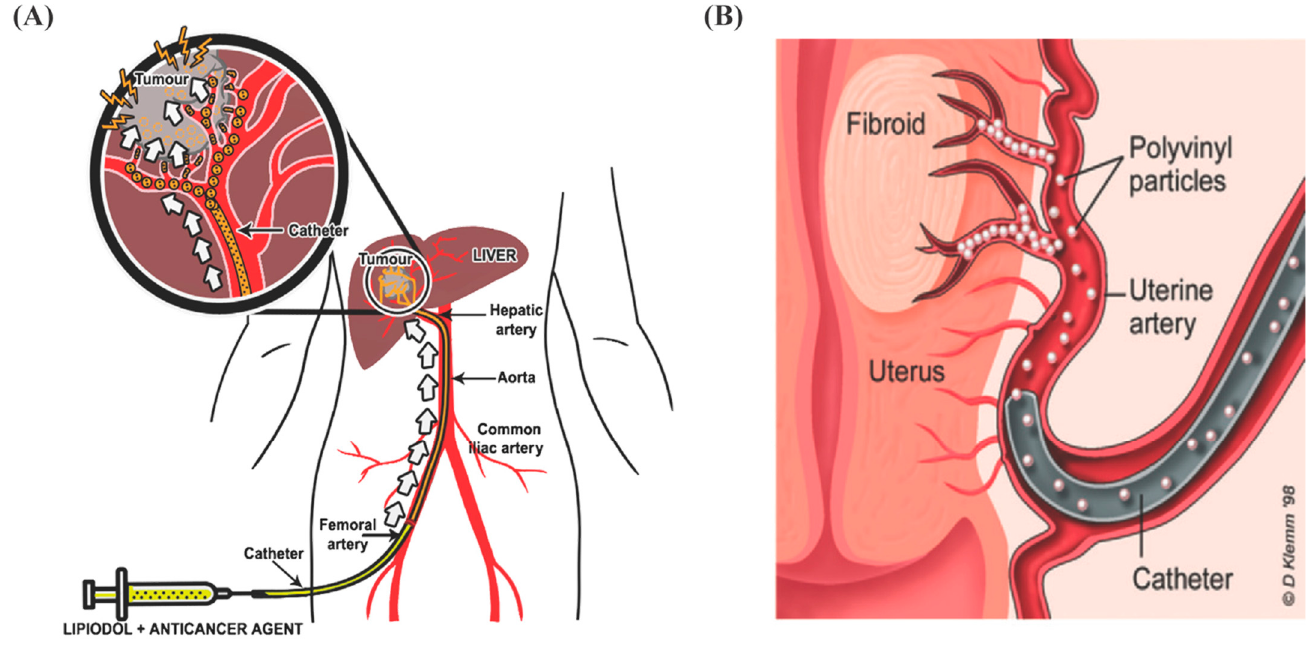
Figure 1. Embolization strategy for the treatment of hepatocellular carcinoma and uterine fibroid. ( A ) Injection of commercial embolic agent Lipiodol combined with anticancer therapeutic agents into the hepatic artery through catheter. Reproduced with permission from Ref. [41]. ( B ) Embolization to treat uterine fibroid by using polyvinyl particles instilled through a catheter. Reproduced with permission from Ref. [49].